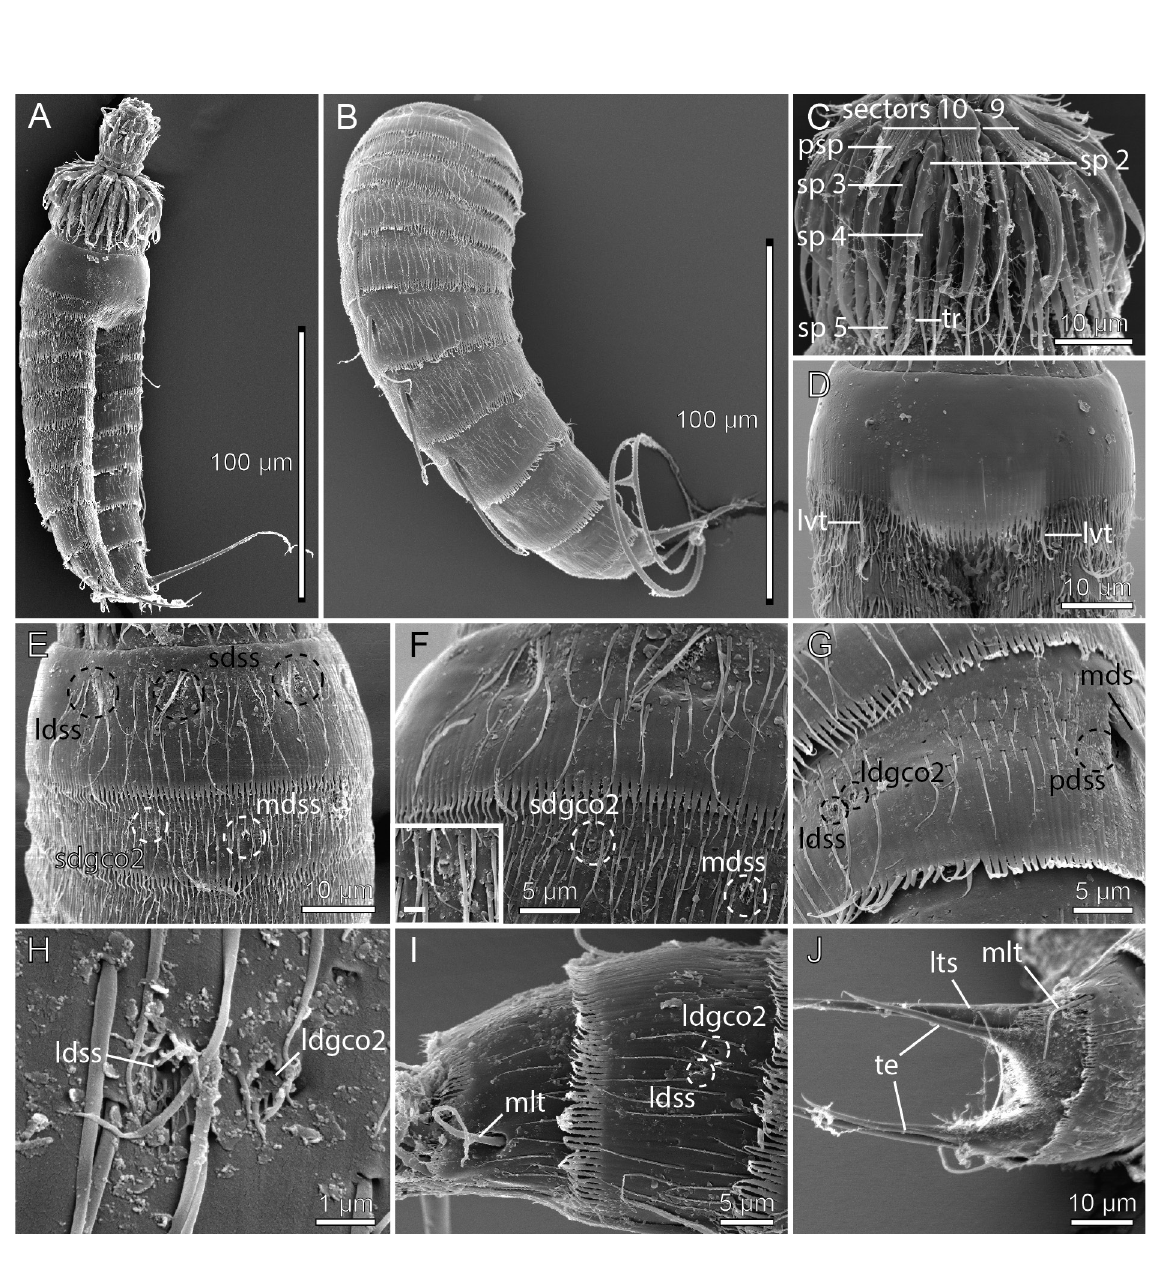
Fig. 20. Scanning electron micrographs showing overviews and details of Echinoderes lupherorum sp. nov. A . Lateroventral overview. B . Laterodorsal overview. C . Introvert sectors 10 and 9. D . Segments 1 to 3, ventral view. E . Segments 1 to 2, dorsal view. F . Detail showing middorsal (right) to laterodorsal (left) parts of segments 1 and 2. Inset shows close-up of subdorsal glandular cell outlet type 2; scale = 1 µm. G . Detail showing middorsal (right) to laterodorsal (left) parts of 8. H . Close-up showing laterodorsal sensory spot and glandular cell outlet type 2 on segment 8. I . Segments 9 to 10, lateral view. J . ♀, segments 10 to 11, dorsal view. Abbreviations: ldgco2 = laterodorsal glandular cell outlet type 2; ldss = laterodorsal sensory spot; lts = lateral terminal spine; lvt = lateroventral tube; mds = middorsal spine; mdss = middorsal sensory spot; mlt = midlateral tube; pdss = paradorsal sensory spot; psp = primary spinoscalid; sdgco2 = subdorsal glandular cell outlet type 2; sdss = subdorsal sensory spot; sp = spinoscalid followed by introvert ring number; te = tergal extensions; tr